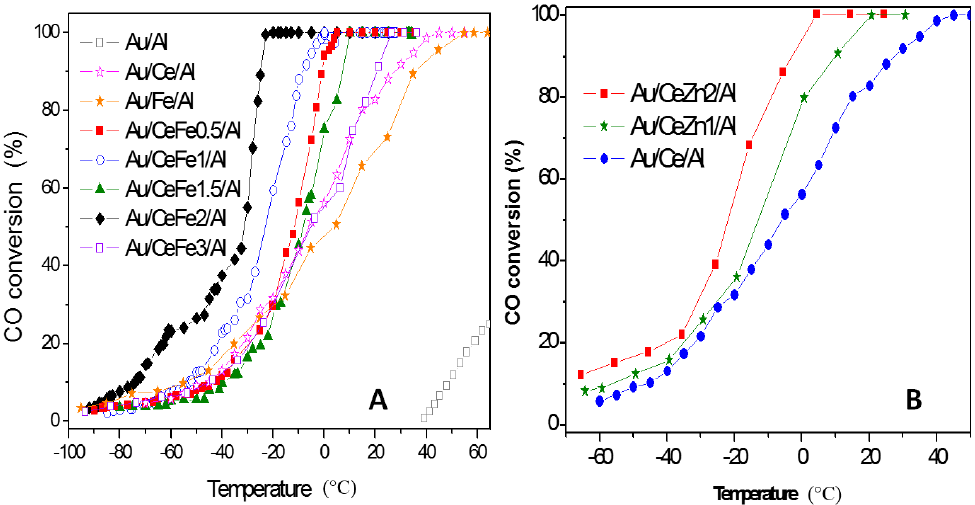
Figure 6. CO oxidation activity of Fe- and Zn-doped Au/CeO 2 /Al 2 O 3 catalysts (reaction conditions: 3.4% CO and 21% O 2 , balanced in helium and Weight Hourly Space Velocity, WHSV, of 31.5 Lg(cat) − 1 · h − 1 ). ( A ) Fe-doped Au/CeO 2 /Al 2 O 3 ; ( B ) Zn-doped Au/CeO 2 /Al 2 O 3 . Reproduced with